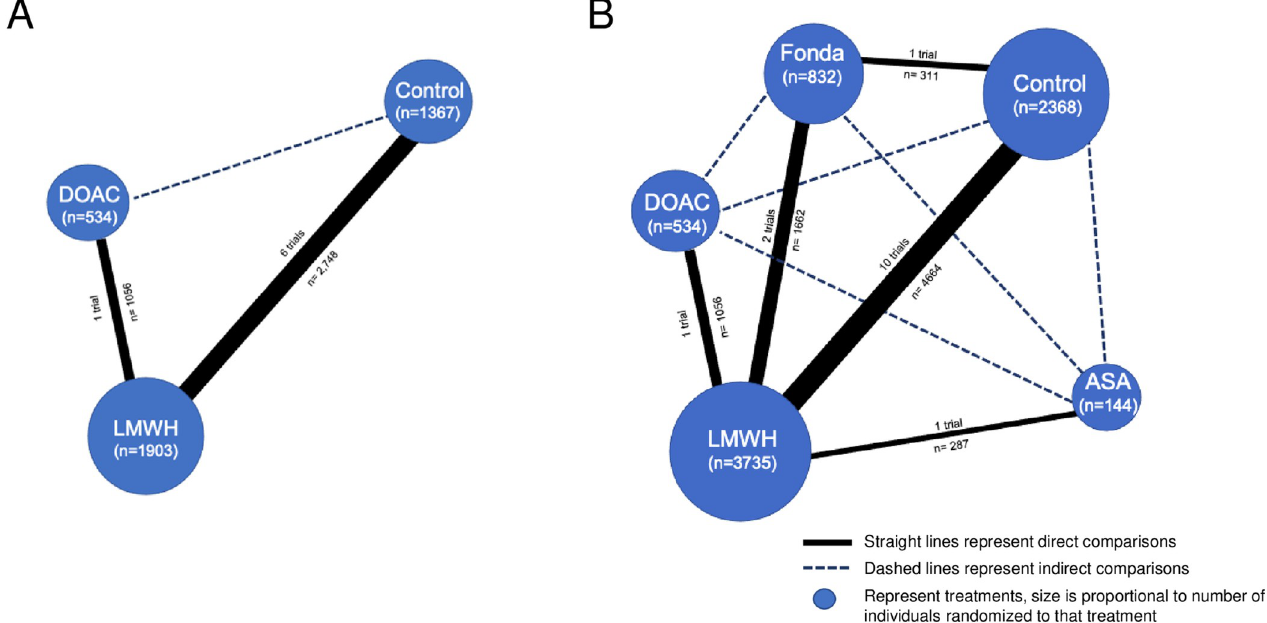
Fig 2. Network graph. (A) Including only RCT with low risk of bias. (B) Including all RCTs. ASA, aspirin; Control, placebo or no treatment; DOAC, direct oral anticoagulant; Fonda, fondaparinux; LMWH, low molecular weight heparin; RCT, randomized controlled trial.